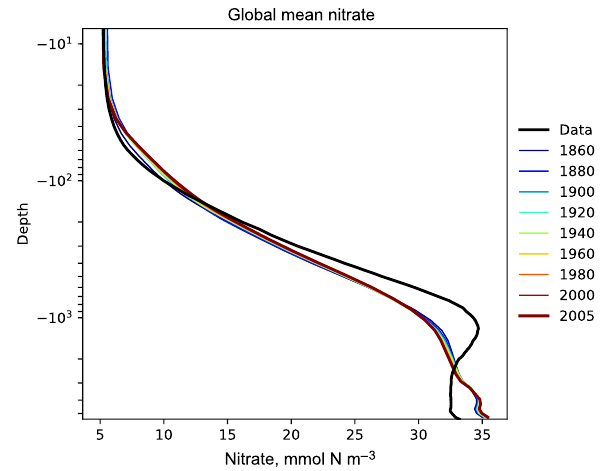
Figure 6. The time development of the global mean dissolved ni- trate over a range of depths. This figure shows the HadGEM2-ES global mean nitrate over the entire water column; each model year is included as a coloured line, and the annual mean of the World Ocean Atlas nitrate climatology dataset is shown as a black